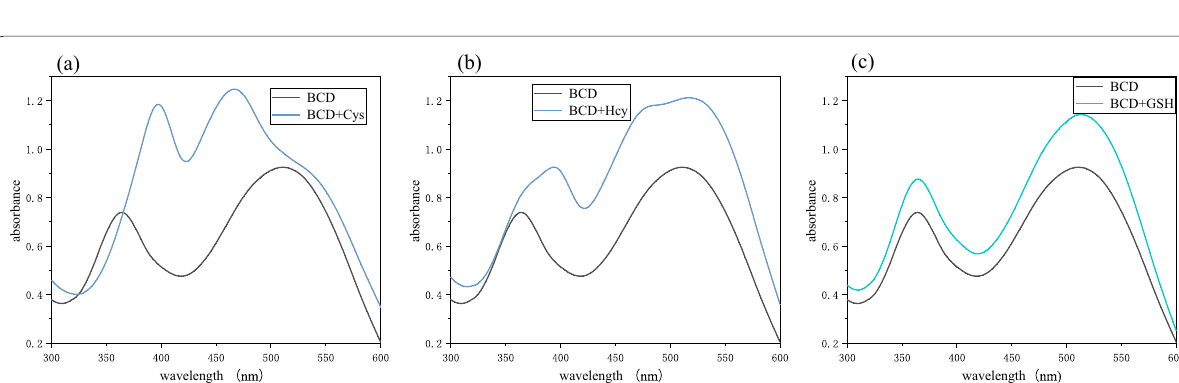
Fig. 5 a UV–Vis absorbance spectra of probe BCD (60 μM) in the absence and presence of Cys (1.4 mM) in the DMF-Hepes buffer (8/2, v/v, pH 7.4). b UV–Vis absorbance spectra of probe BCD (60 μM) in the absence and presence of Hcy (1.4 mM) in the DMF-Hepes buffer (8/2, v/v, = pH 7.4). c UV–Vis absorbance spectra of probe BCD (60 μM) in the absence and presence of GSH (1.4 mM) in the DMF-Hepes buffer (8/2, v/v, = pH 7.4) =